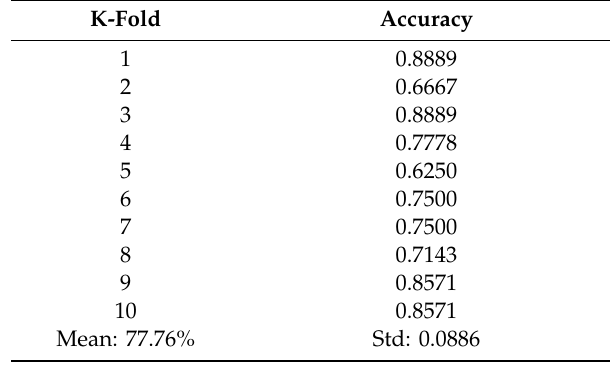
Figure 18. The best parameters with obtained after performing Grid Search with 5-Fold Cross- Validation on the RF model. Table 4. Accuracies achieved by performing 10-Fold Cross-Validation on the RF model.